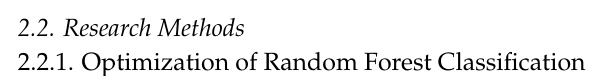
Table 1. Data source information.